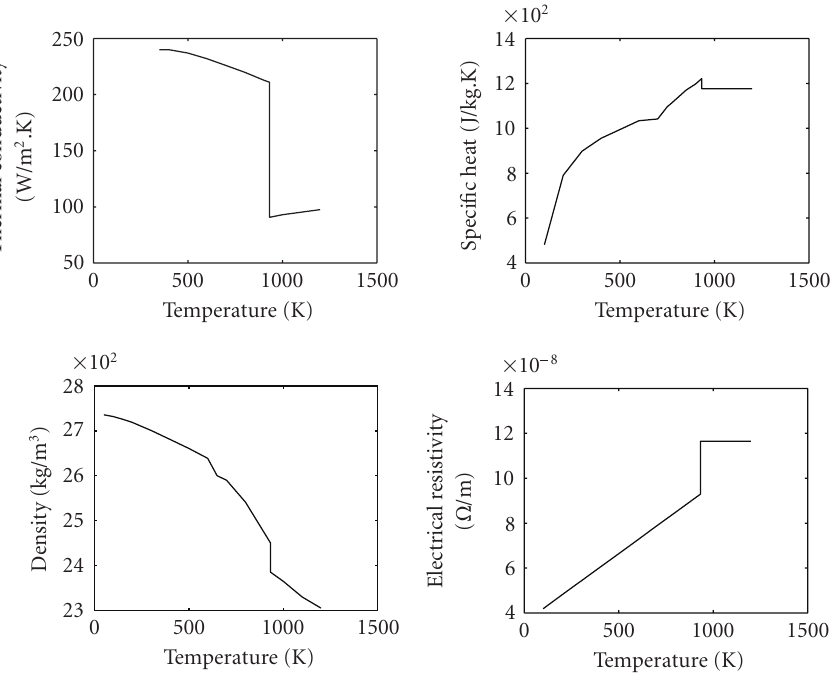
Figure 4.1. Temperature dependent properties for Aluminum. The melting temperature is 933.2